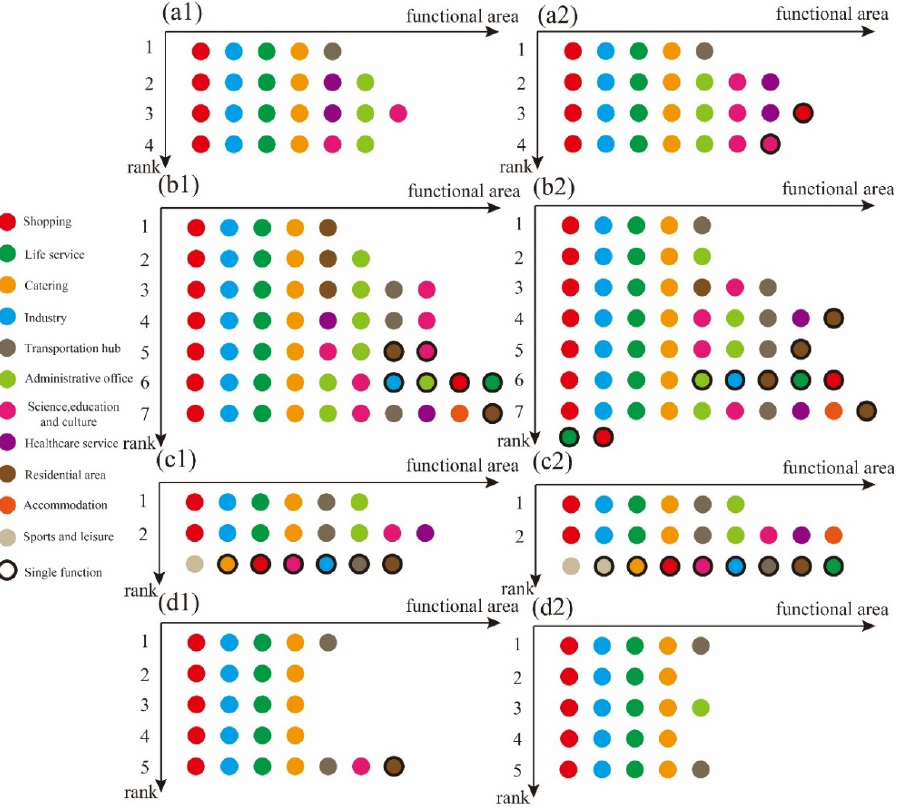
Figure 5. Statistical diagram of correlation characteristics for different ranks. ( a1 ): Beijing–Tianjin– Hebei, correlation with other functional areas; ( a2 ): Beijing–Tianjin–Hebei, correlation with non ‐ built ‐ up area; ( b1 ): the Yangtze River Delta, correlation with other functional areas; ( b2 ): the Yangtze River Delta, correlation with nonbuilt ‐ up area; ( c1 ): Chengdu–Chongqing, correlation with other functional areas; ( c2 ): Chengdu–Chongqing, correlation with nonbuilt ‐ up area; ( d1 ): the Pearl River Delta, correlation with other functional areas; ( d2 ): the Pearl River Delta, correlation with nonbuilt ‐ up area.